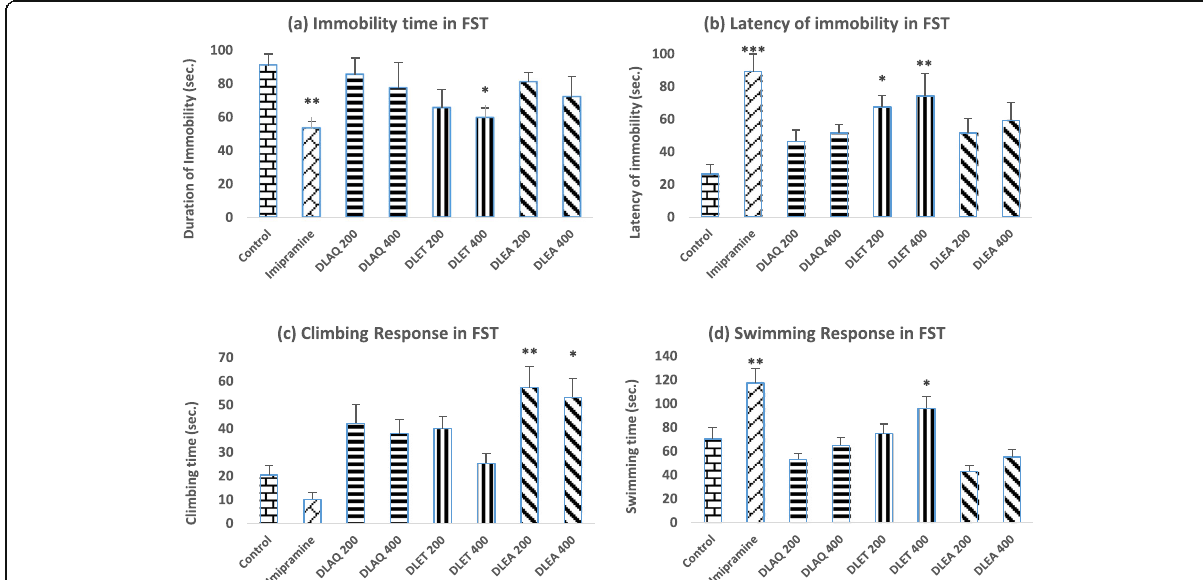
Fig. 2 a - d : Observation parameters of Forced Swim Test (FST). Figure represented the duration of immobility ( a ), latency of immobility ( b ), climbing time ( c ) and swimming time ( d ) measured in seconds exhibited by the respective groups of mice. DLAQ = Aqueous extract of D. linearis , DLET = Ethanol extract of D. linearis , DLEA = Ethyl Acetate extract of of D. linearis . Data represented as mean + SEM and analyzed by one-way ANOVA followed by Dunnett t test where *, **, *** denoted p < 0.05, p < 0.01 and p < 0.001 respectively and statistically significant. All groups